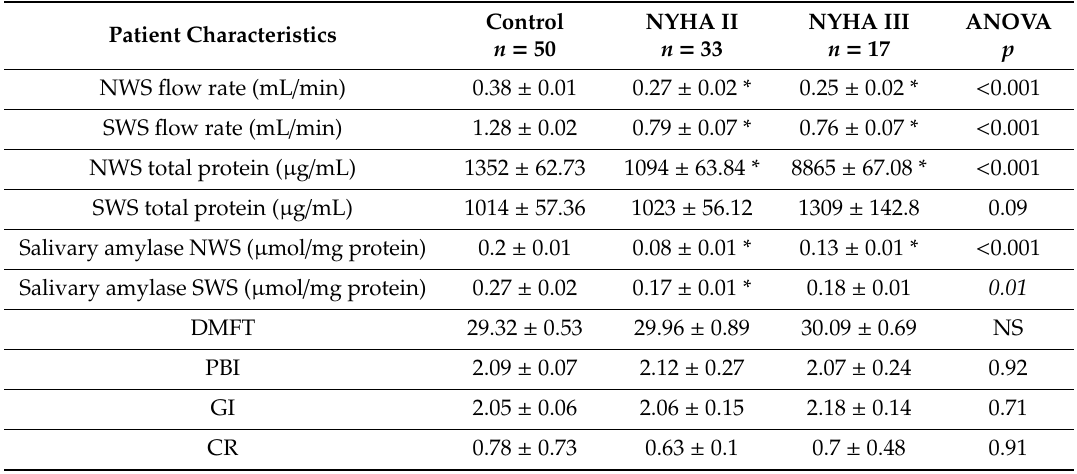
Table 2. Salivary gland function and stomatological characteristics of HF patients and control subjects. Patient